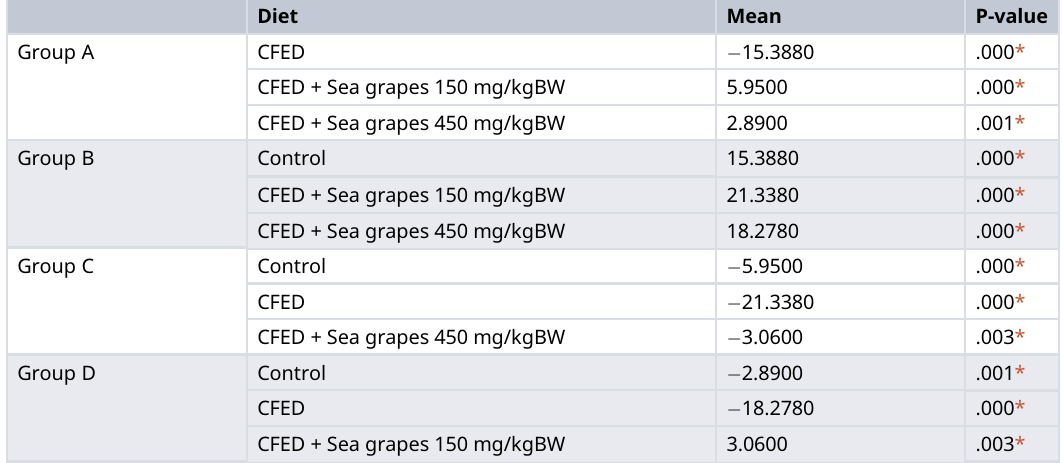
*Represents p-value <0.05, CI: 95%.